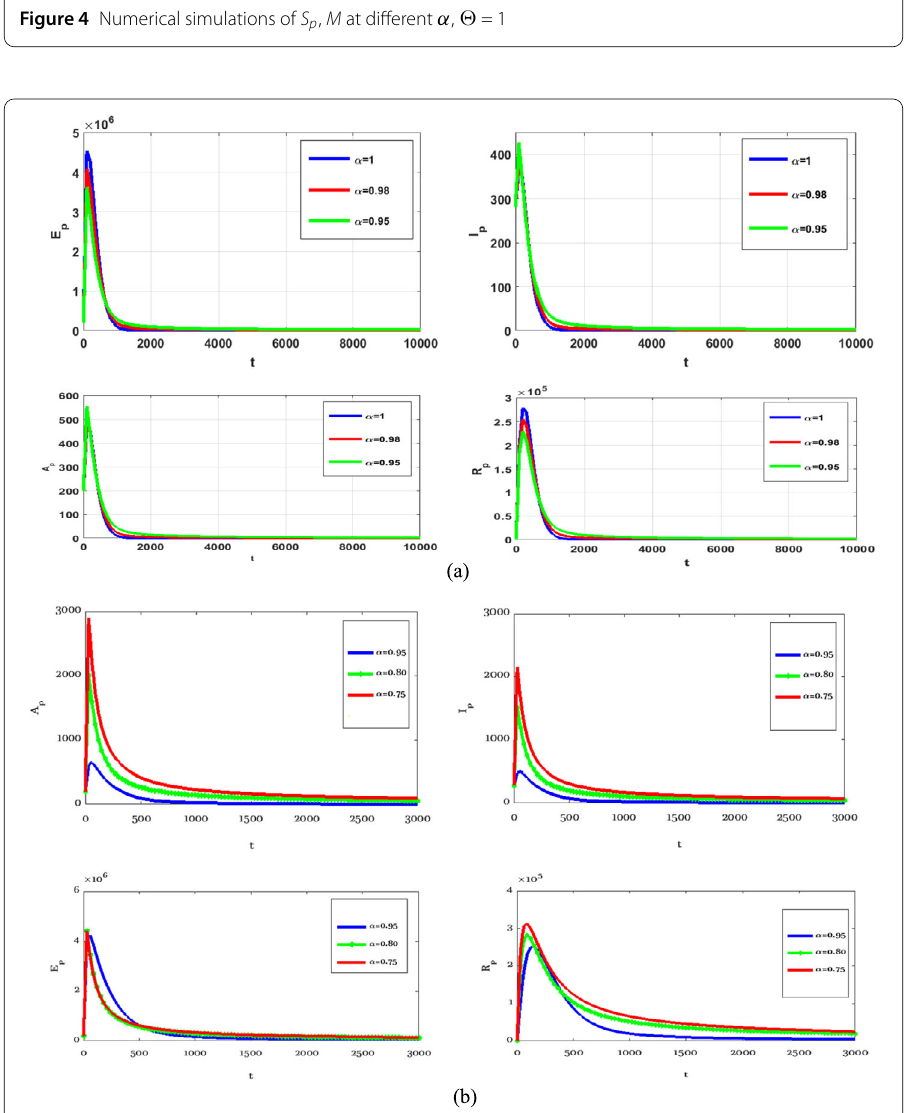
Figure 5 Numerical simulations of E p , I p , A p , and R p at different α , (cid:21) = 1, T f = 3000,10,000 with